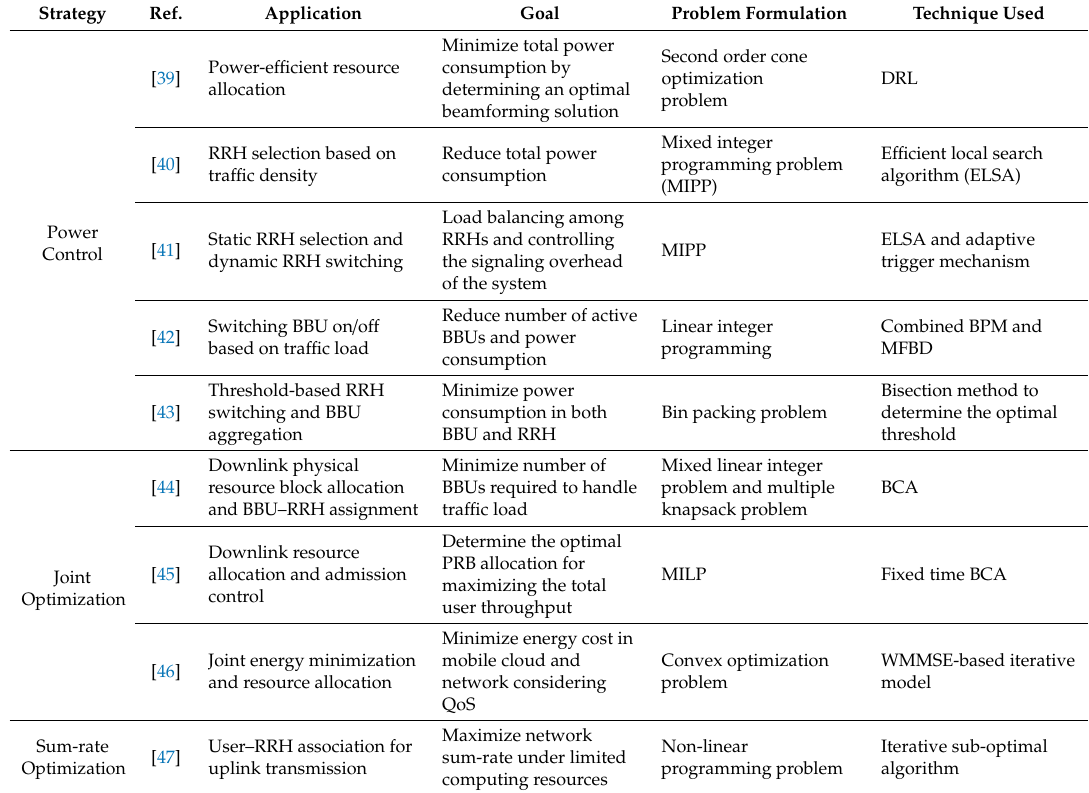
Table 2. Radio resource management techniques in